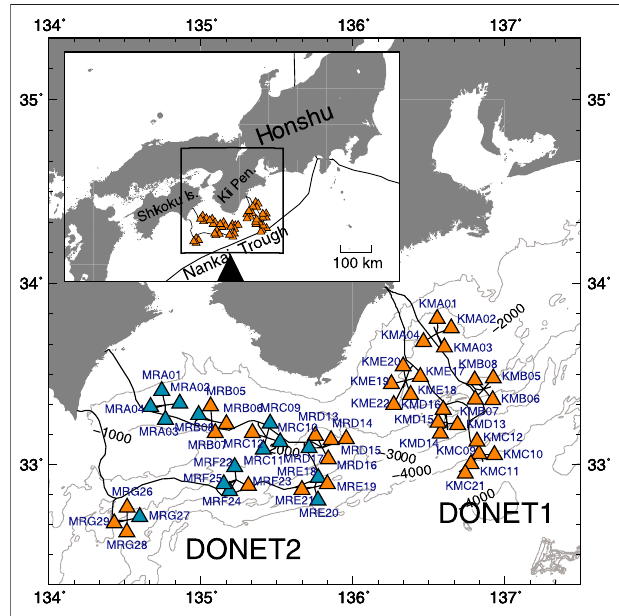
FIGURE 1 | Observatories and submarine cable layout of DONET denoted by triangles and solid lines, respectively. The blue triangles represent the speci fi cstations inwhich pressure sensors wereinstalled after thepresent